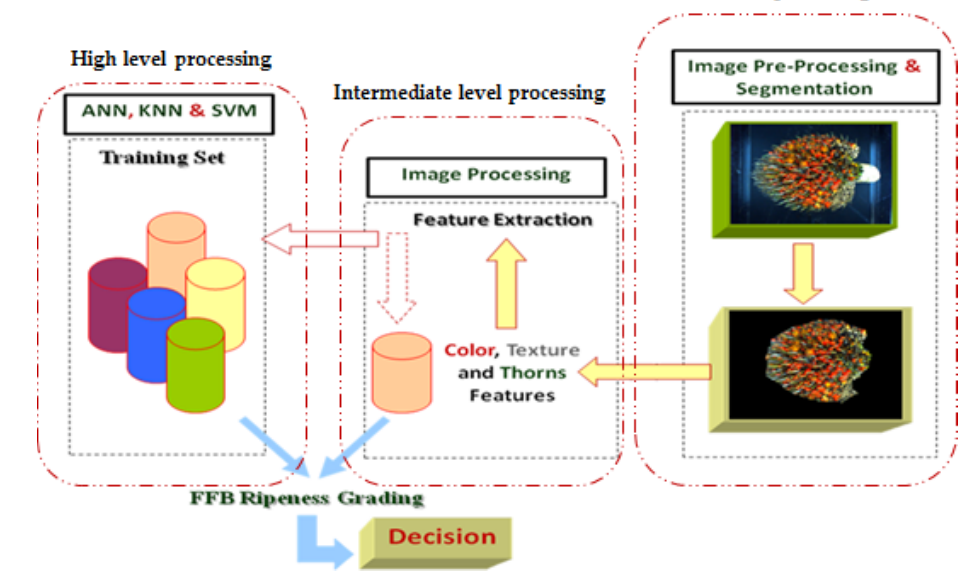
Figure 11. Image processing algorithms levels for FFB ripeness